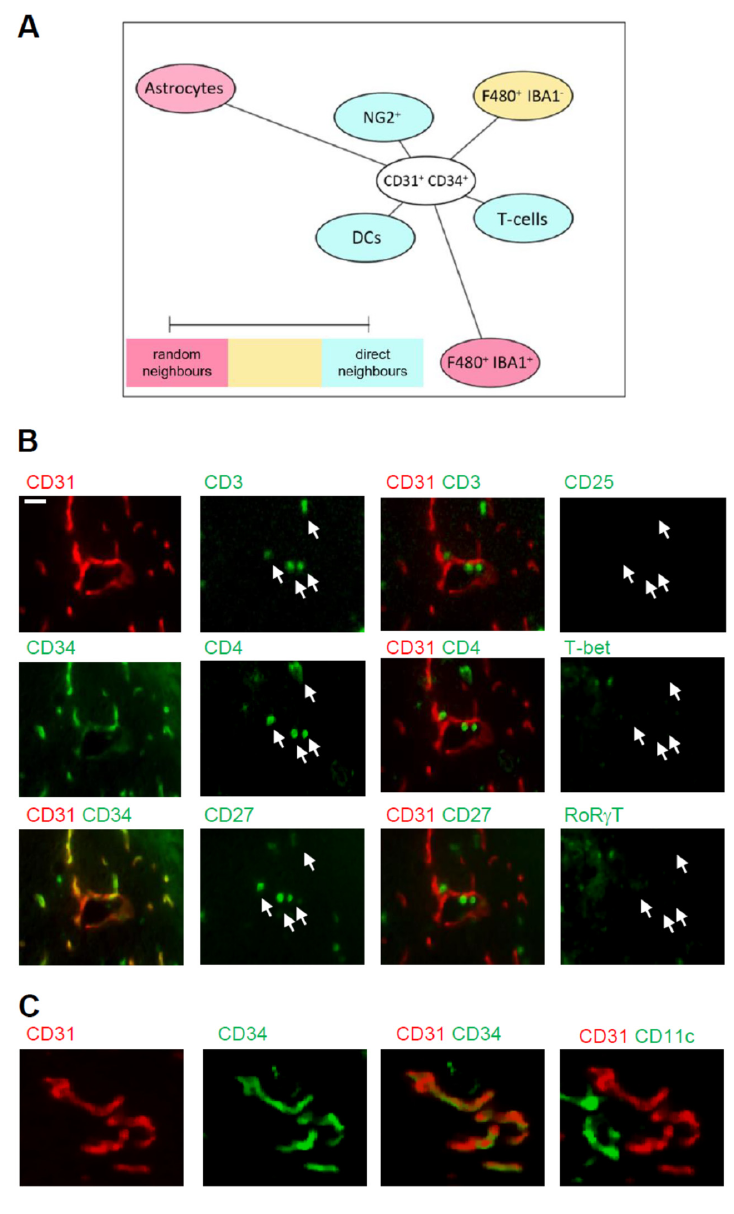
Figure 6. Cellular neighborhood of CD31 + /CD34 + endothelial cells in the IC-ANV. ( A ) Network visualization using Cytoscape of the cellular neighborhood of CD31 + /CD34 + endothelial cells in the IC-ANV 28 days after stroke induction. The distance between CD31 + /CD34 + cells and the other cell types in the visualization represents the statistical probability of being direct neighbors. ( B , C ) Representative MELC images showing T-cells (panel ( B )) and dendritic cells (panel ( C )) in the neighborhood of CD31 + /CD34 + endothelial cells in the IC-ANV at the indicated times. The white bar represents 10 µ